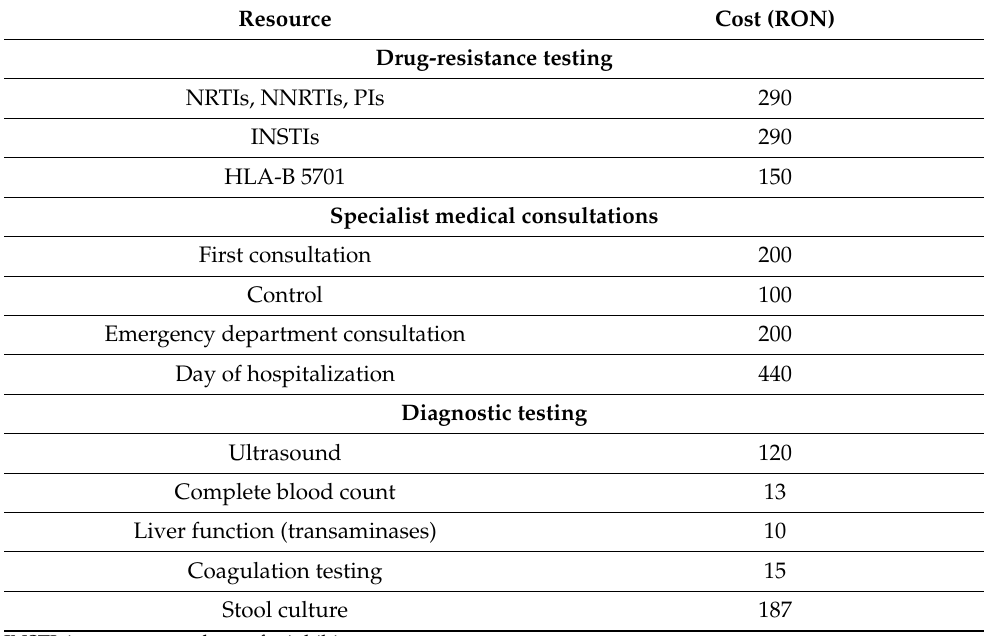
Table 2. Direct cost per patient associated with ART, not including the cost of drugs, as requested by the software